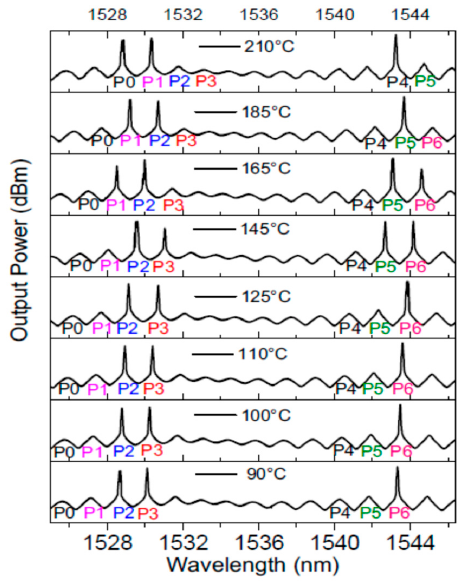
Figure 8. Laser emission response for temperature variation from 90 °C to 210 °C.